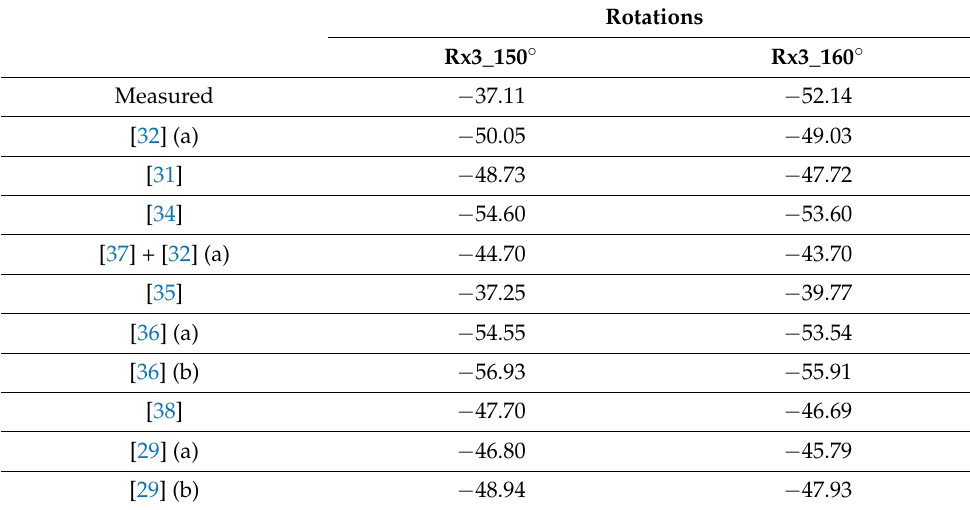
Table 5. Performance comparison between references from literature and measurements at the third receiver